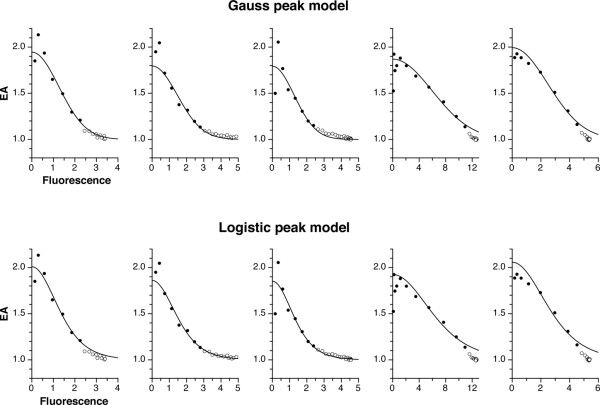
Efficiency of amplification can be described as a function of fluorescence with a Gauss peak or a logistic peak model. For each amplicon described in Table 2 (same order, left to right corresponds to top to bottom), the third fluorescence curve (arbitrarily chosen; numbering refers to the Excel raw data file [see Additional file 5]) was analyzed. After subtraction of linear background, EA was calculated as Fi/Fi-1 ratio and plotted against fluorescence (Fi) as shown. To avoid confusion, points with Fi < 0.1 are not displayed; most of these, because of large errors in EA, lie outside the y axis range. The line graphs were drawn with the Gauss peak function (upper row) or the logistic peak function (lower row). Note that function parameters were not fitted to the points shown, but determined by our stepwise PCR simulation approach based on the raw fluorescence versus cycle number data. Open circles represent data that was not used for fitting.